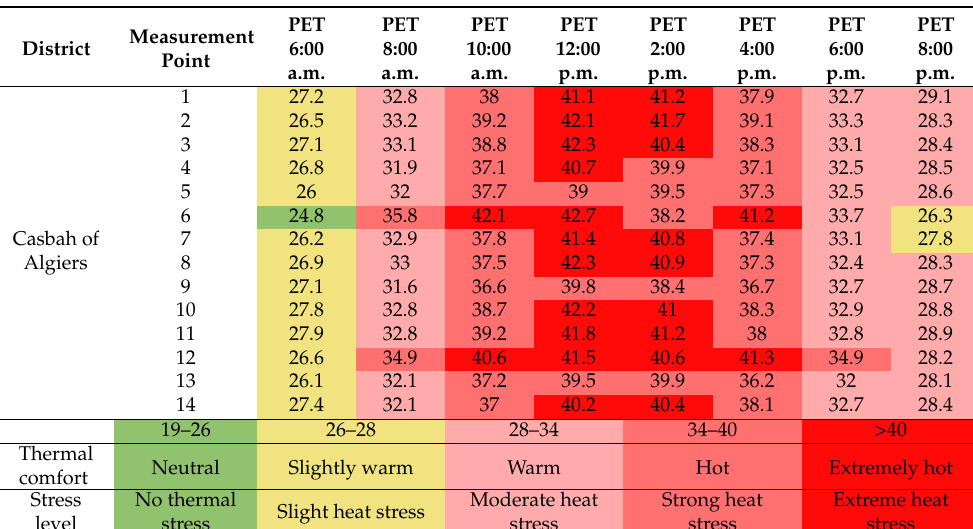
Table 6. Assessment of the outdoor thermal comfort level stress via PET index in the 14 study cases in August